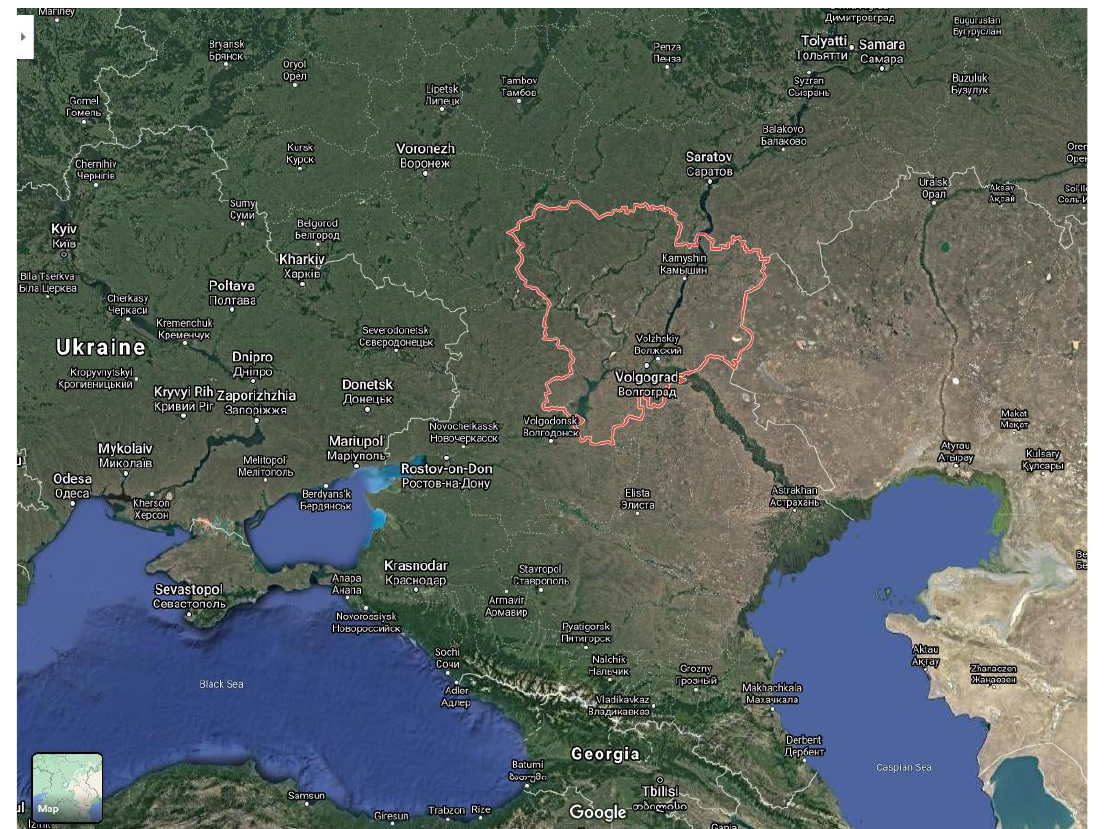
Figure 1. Volgograd region of the Russian Federation (administrative border highlighted in red). Satellite map (medium scale) from https://www.google.com/maps (accessed on 29 December 2021). Table 1. Solar radiation in the Lower Volga region